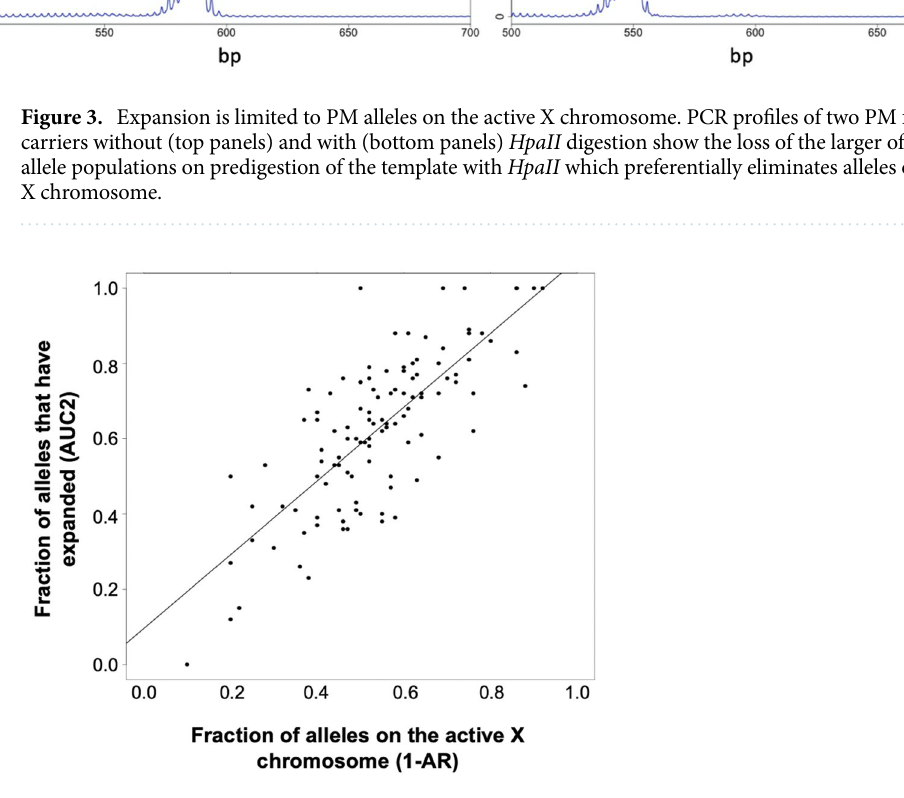
Figure 4. Correlation between the percentage of PM alleles on the active X chromosome and the fraction of alleles that have